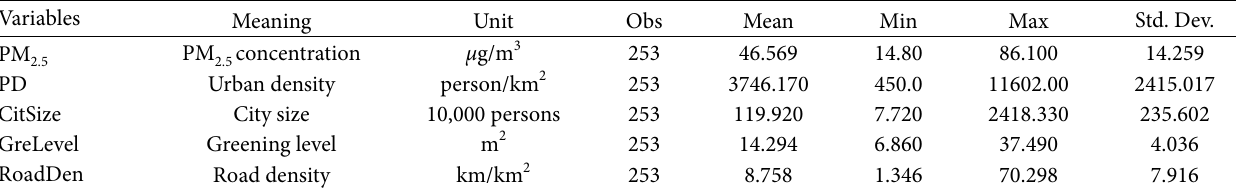
Table 1: Descriptive statistics of the variables used in this study.